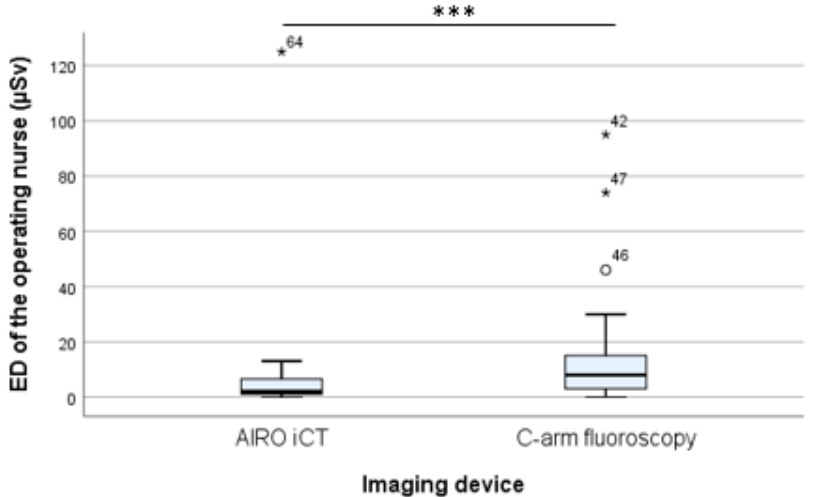
Figure 3. Effective dose (ED) of the operating nurse during an MI-PLIF procedure. The ED of the oper- ating nurse ( µ Sv) compared between surgeries assisted by iCT ( n = 24) or C-arm fluoroscopy ( n = 42). Extreme values are marked as “ (cid:70) ” and outliers are marked as “ ◦ ” on the boxplot. Significance ( p < 0.001) is indicated with “***” above the two